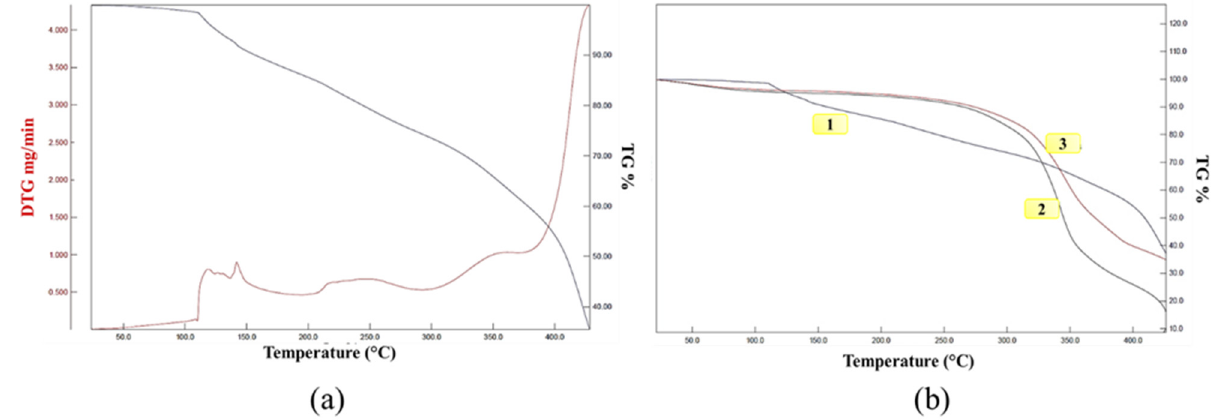
Figure 5. ( a ) Thermogravimetric analysis (TGA) of uncured mixture acrylic resin; ( b ) Uncured mixture resin (curve 1), DS/KEFL (curve 2), and DS/23BA/KEFL (curve 3).